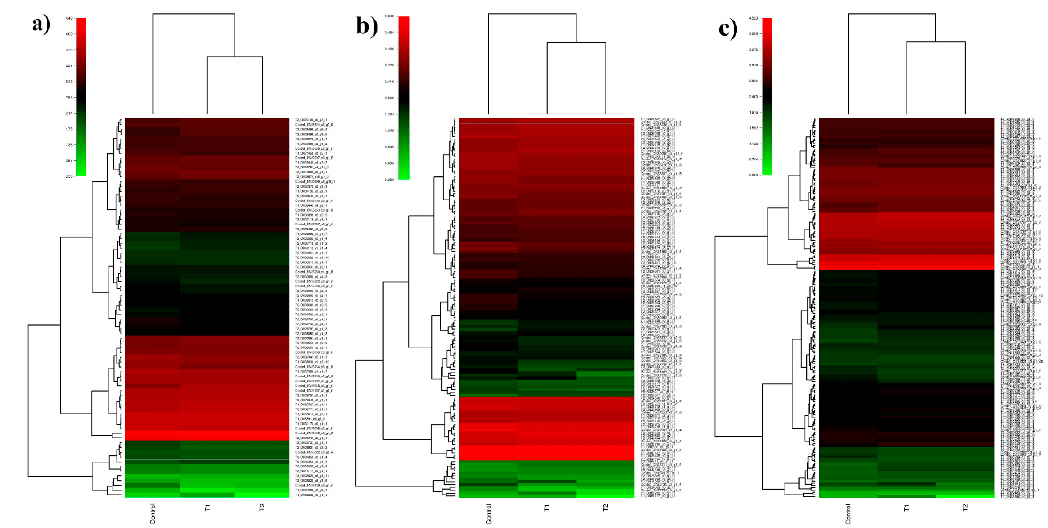
Figure 8. Differential gene expression pattern of selected KEGG pathway in H. persicum : ( a ) heat map showing the DGEs of MAPK-signaling genes in the control, T1 (48 h PEG treatment), and T2 (72 h PEG treatment) samples; ( b ) heat map showing the DGEs of plant-hormone signal transduction pathway genes in the control, T1, and T2 samples; ( c ) heat map showing the DGEs of plant pathogen interaction pathway genes in the control, T1, and T2 samples.